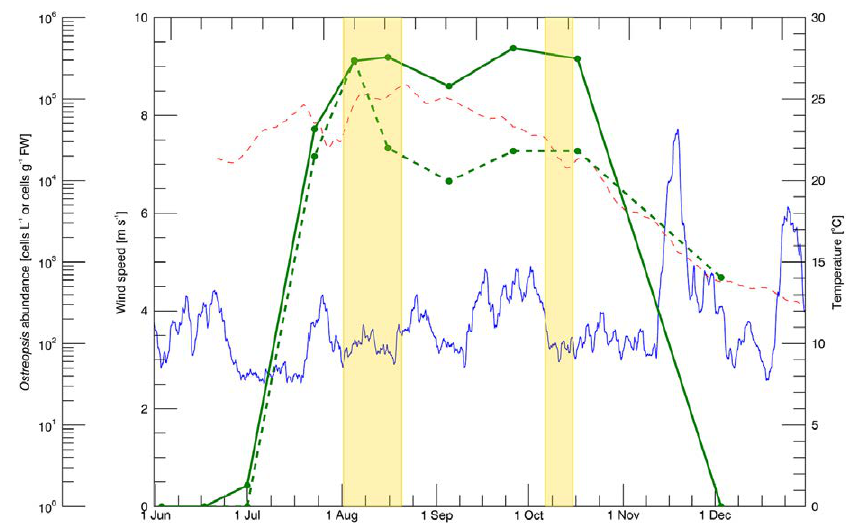
Fig. 2. – Temporal evolution of wind intensity (blue line) and water temperature (dashed red line) along with the epiphytic (solid green line, cells g –1 FW) and planktonic (dashed green line, cells L –1 ) concentrations of Ostreopsis cf. ovata in the second half of 2013. Wind and tempera- ture data were low-pass filtered using a cut off period of 7 days (running mean). Painted areas indicate the periods of human health affectation.